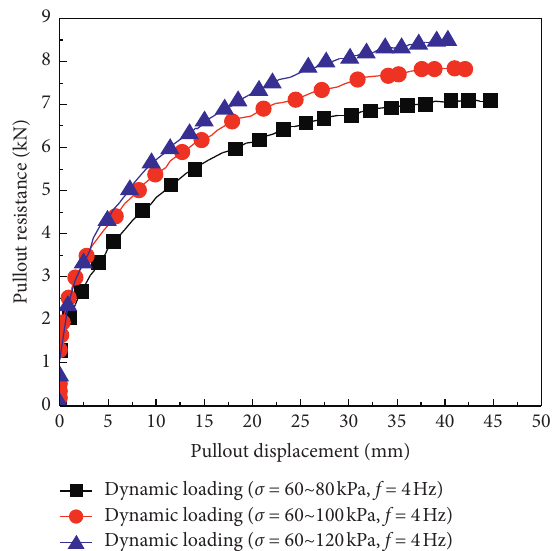
Figure 11: The curve of the pullout displacement versus pullout resistance under dynamic